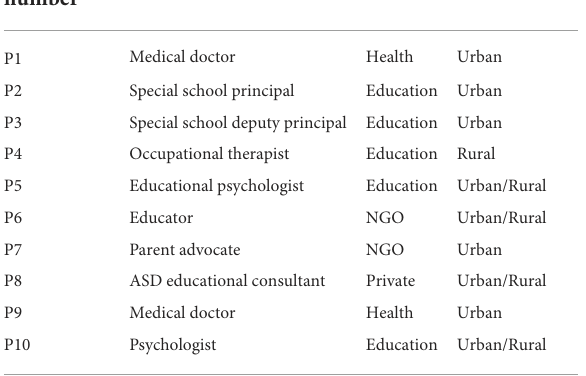
TABLE 1 Participant characteristics.